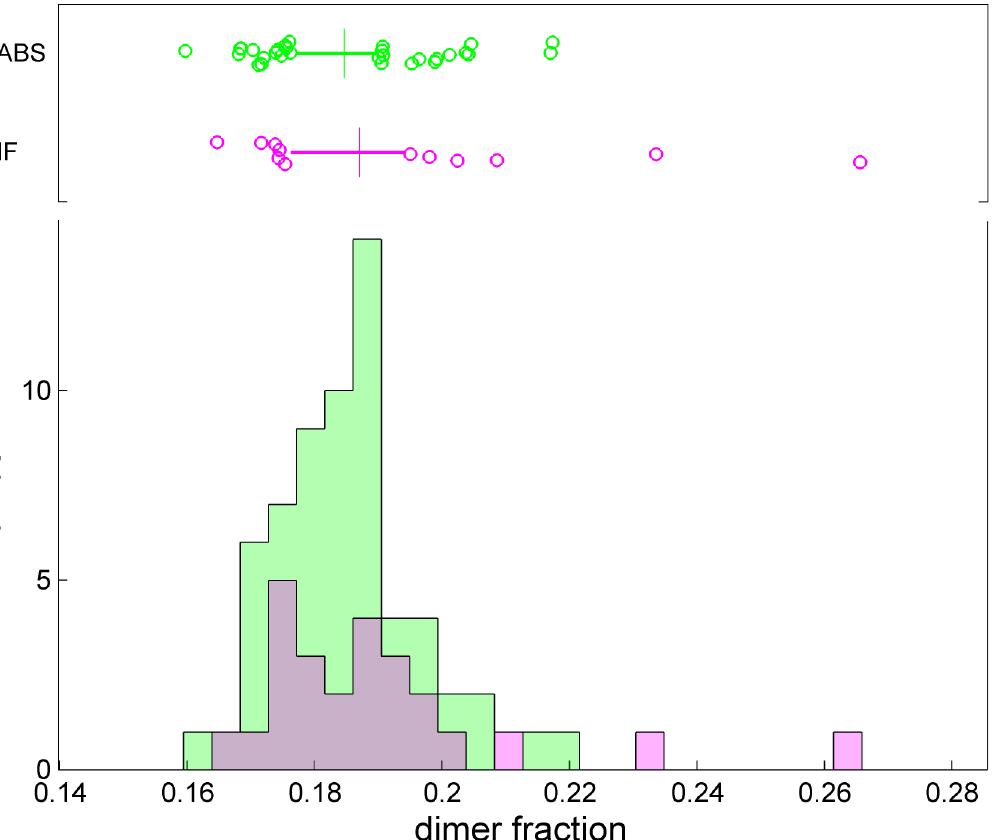
Fig 12. Observed fraction of dimer (as a ratio of dimer peak area to the sum of monomer plus dimer peak areas). The box-and-whisker plot indicates the central 50% of the data as solid line and draws the smaller and larger 25% percentiles as individual circles. The median displayed as vertical line. The mean and standard deviations are 18.5% ± 1.1% for the absorbance system, and 19.0% ± 2.1% for the interference